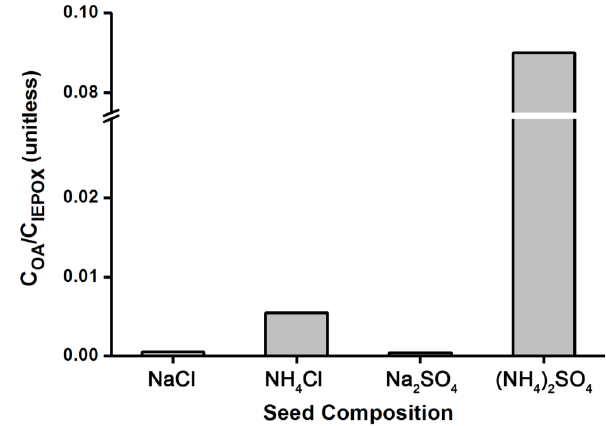
Fig. 4. Ratio of organic aerosol produced to gas-phase trans β - IEPOX injected for seeds of various compositions (RH